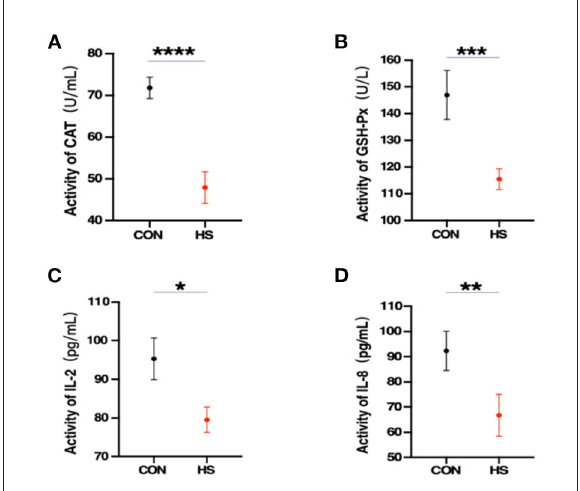
FIGURE2 (A–D) Serum oxidative and immune biomarkers levels ( n = 3 per group) from the HS group and CON group. CAT , catalase; GSH-Px , glutathione peroxidase; IL-2 , interleukin 2; IL-8 , interleukin 8. *, **, *** and **** indicated statistically significant